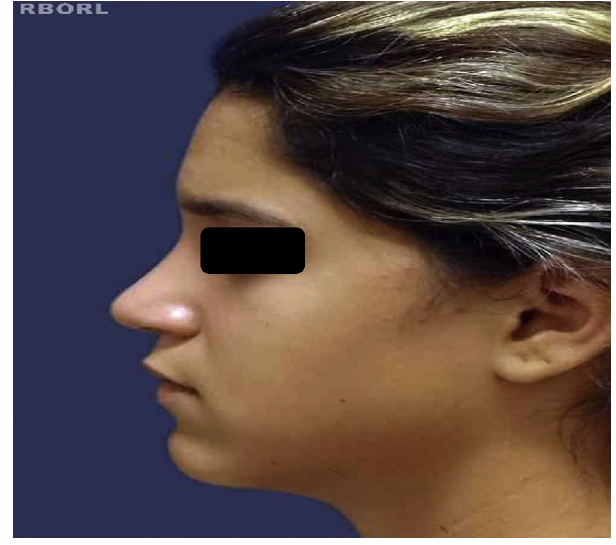
Figure 5 Postoperative profile picture.